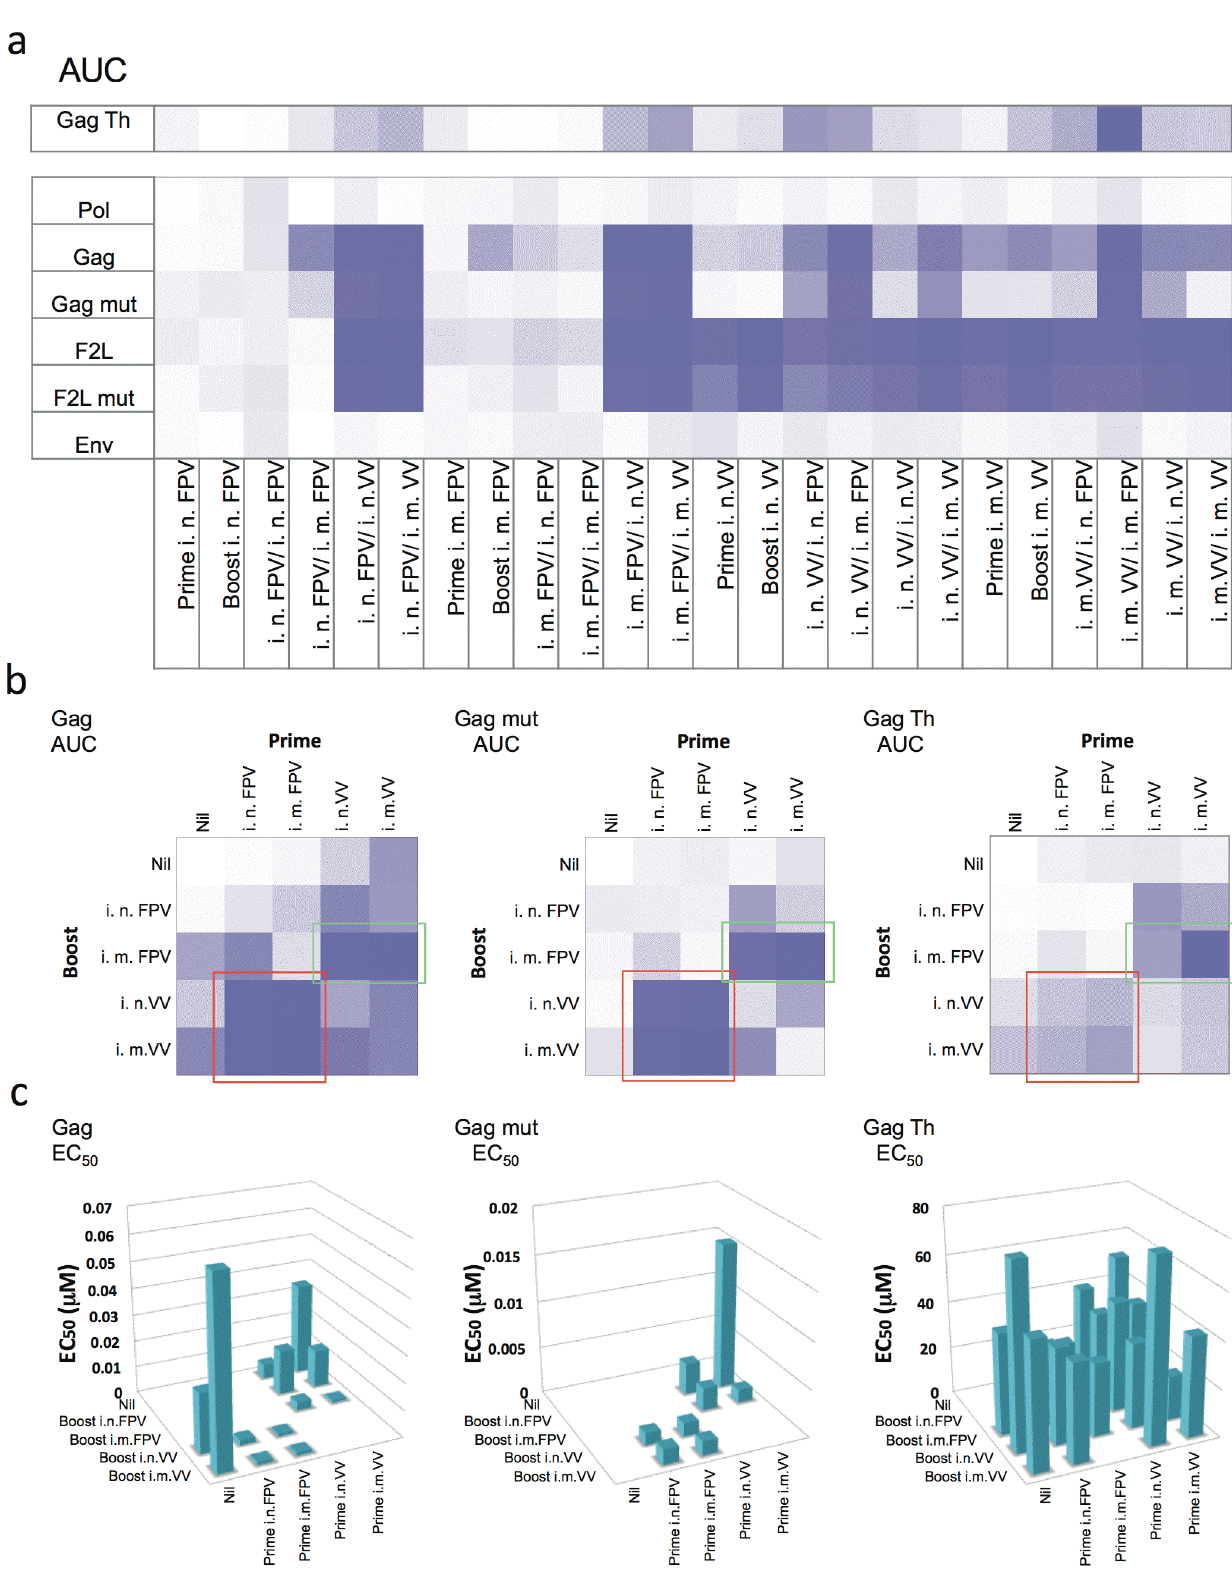
Figure 3. High throughput screening of HIV-1 poxvirus vaccination regimes for high magnitude, high functional avidity and high epitope variant cross-reactive T cell responses invivo . Mice were vaccinated with 24 different vaccine regimes based on all combinations of FPV-HIV and VV-HIV administered either i.n. or i.m. in a prime-boost strategy as outlined in Table 1. Mice were vaccinated with 5 6 10 6 PFU of each vaccine and booster vaccinations were given 2 weeks after the priming vaccination. T cell responses were assessed using a 252-parameter FTA